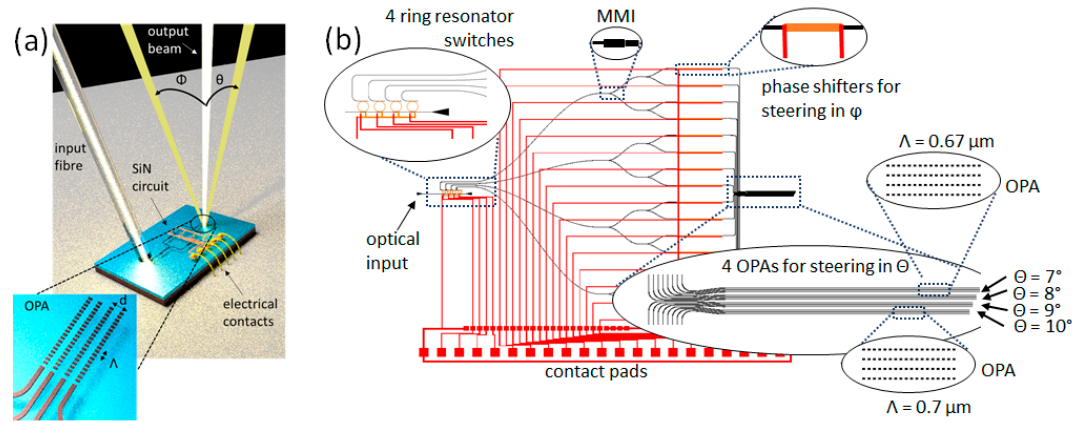
Figure 6. ( a ) Artistic illustration of an integrated OPA. The output beam (depicted in white) can be steered in two dimensions (represented in yellow). ( b ) Schematic image of the proposed two-dimensional beam steering circuit. A switching network allows access to four different OPAs, each with a distinct emission angle in θ . Phase shifters allow the introduction of a phase difference between the OPA channels for beam steering in Φ .